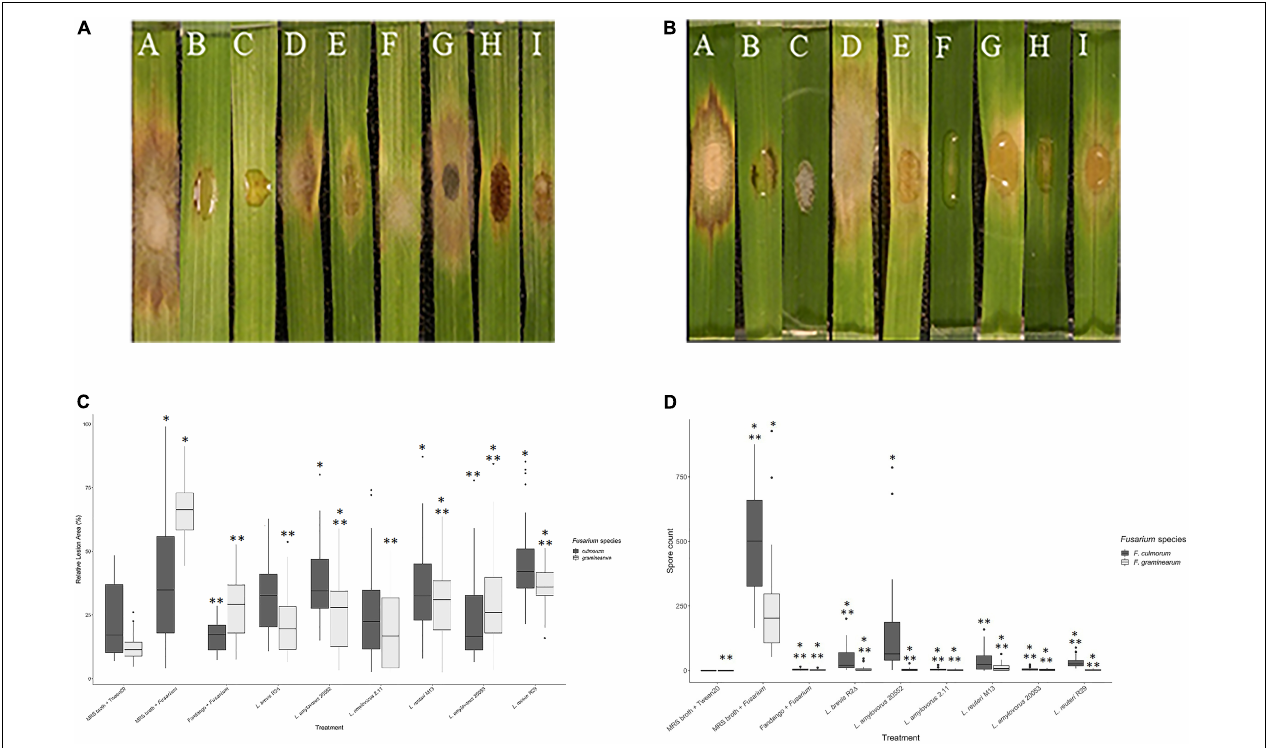
FIGURE 2 | Effect of lactic acid bacteria on the mycelial growth of Fusarium spp. using detached leaf assay. (A) Treatments were applied simultaneously. Disease estimation was calculated by measuring the relative lesion area at 120 h post-inoculation. * Indicates treatments significantly different than the control MRS broth + Tween 20 ( F. graminearum ). ** Indicates treatments significantly different than the control MRS broth + F. graminearum . (B) Symptomatic diseased lesions on barley leaves. The barley leaves were treated with F. graminearum and controls [(A) MRS broth + F. graminearum , (B) Fandango R (cid:13) + F. graminearum (C) MRS broth + Tween 20]. MRS broth and lactic acid bacteria [(D) L. reuteri R29, (E) L. brevis R2 (cid:49) , (F) L. amylovorus FST2.11, (G) L. reuteri M13, (H) L. amylovorus DSM 20053, and (I) L. amylovorus DSM 20552]. The effects of the treatments above were observed 120 h post-inoculation. (C) Symptomatic diseased lesions on barley leaves treated with F. culmorum and controls [(A) MRS broth + F. culmorum , (B) Fandango R (cid:13) + F. culmorum (C) MRS broth + Tween 20]. MRS broth and lactic acid bacteria [(D) L. reuteri R29, (E) L. brevis 2 (cid:49) , (F) L. amylovorus FST 2.11, (G) L. reuteri M13, (H) L. amylovorus DSM 20053, and (I) L. amylovorus DSM 20552]. The effects of treatments above observed 120 h post-inoculation. (D) An assessment of LAB treatments on sporulation of Fusarium spp. by detached leaf assay. Conidia production was determined 5 days post-inoculation. *** Indicates treatments significantly different than the control MRS broth + Tween 20 ( F. culmorum ). **** Indicates treatments significantly different than the control MRS broth + F. culmorum . * Indicates treatments significantly different than the control MRS broth + Tween 20 ( F. graminearum ). ** Indicates treatments significantly different than the control MRS broth + F. graminearum.